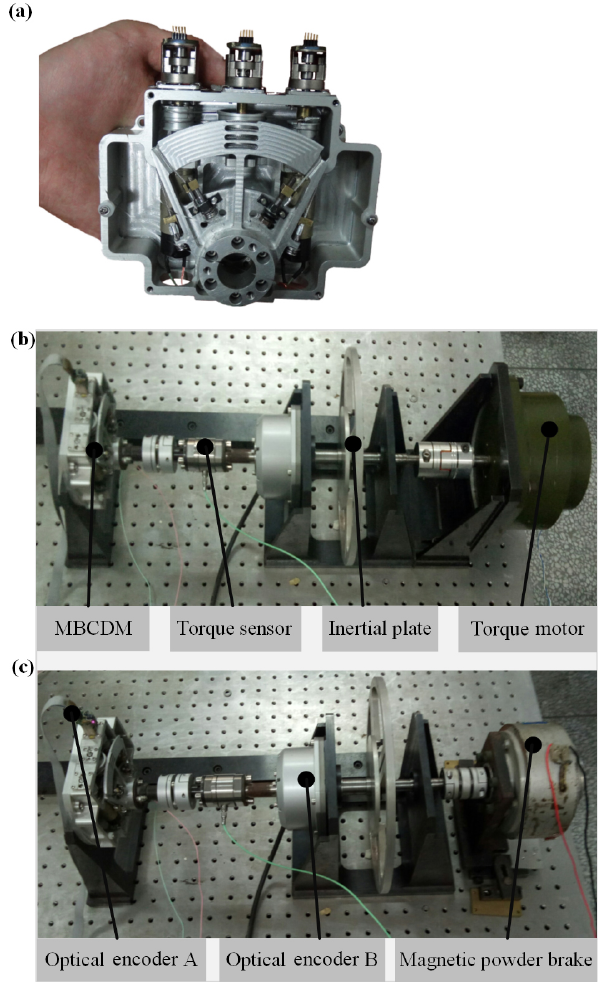
Figure 6. Experimental setups of MBCDM: (a) prototype of the MBCDM; (b) driving capability test; (c) transmission backlash test.